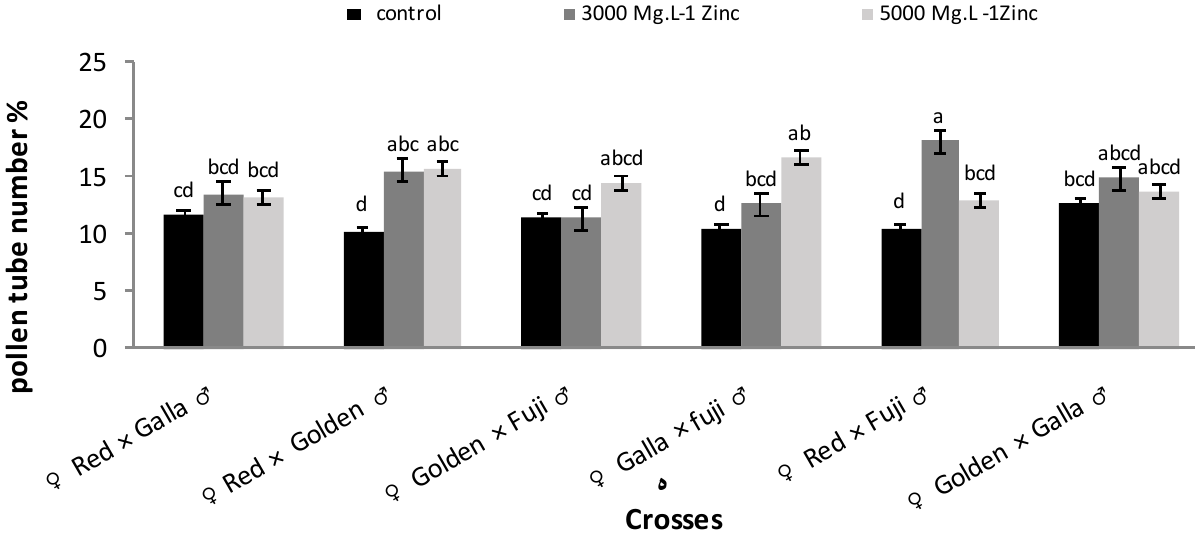
Fig. 4. The interactions between Zn concentration and crosses on the pollen tube penetration into the middle part of the style in different crosses. Means in each column, followed by similar letter (s) are not significantly different at 1% probability level.